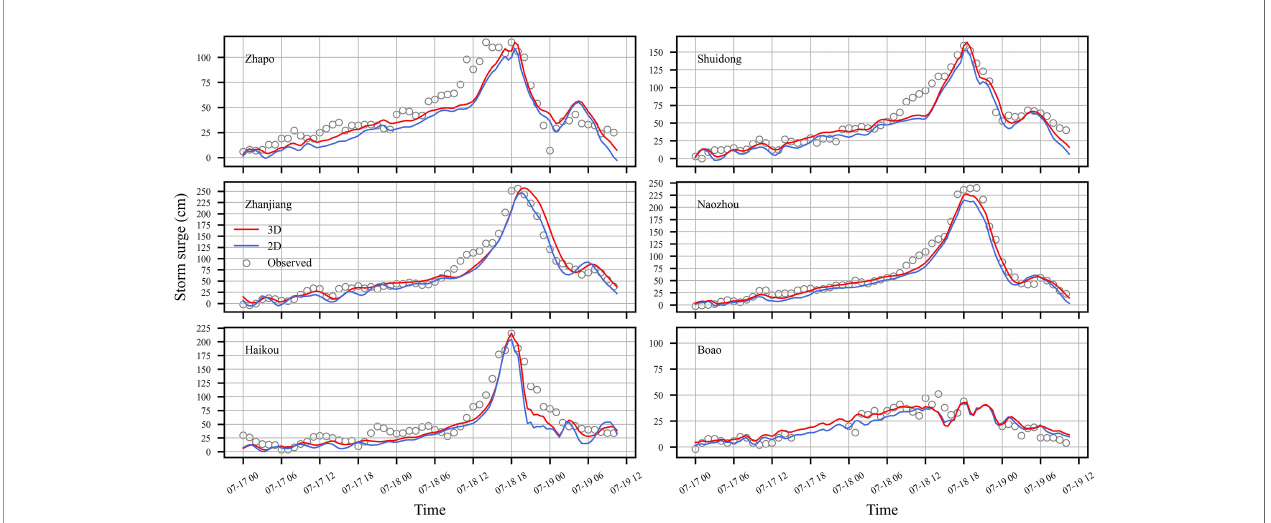
FIGURE 6 | Time series of observed (circles) and simulated storm surges (cm) under the 2-D (blue line) and 3-D (red line) mode conditions at six tide gauge stations.